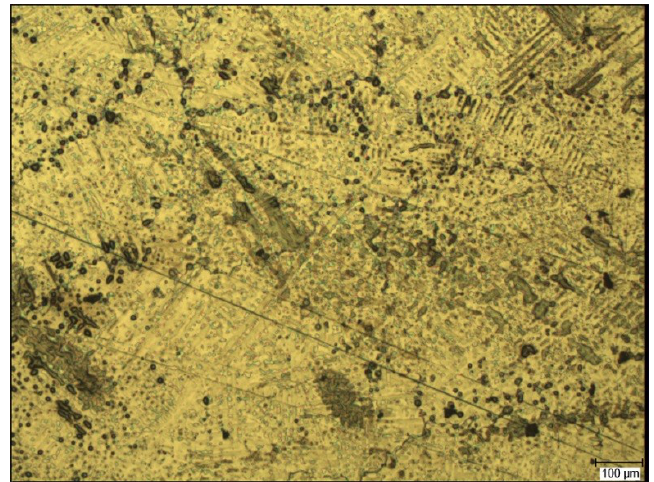
Figure 9. Microstructure of a cross-section of the CM sample. Magnification: